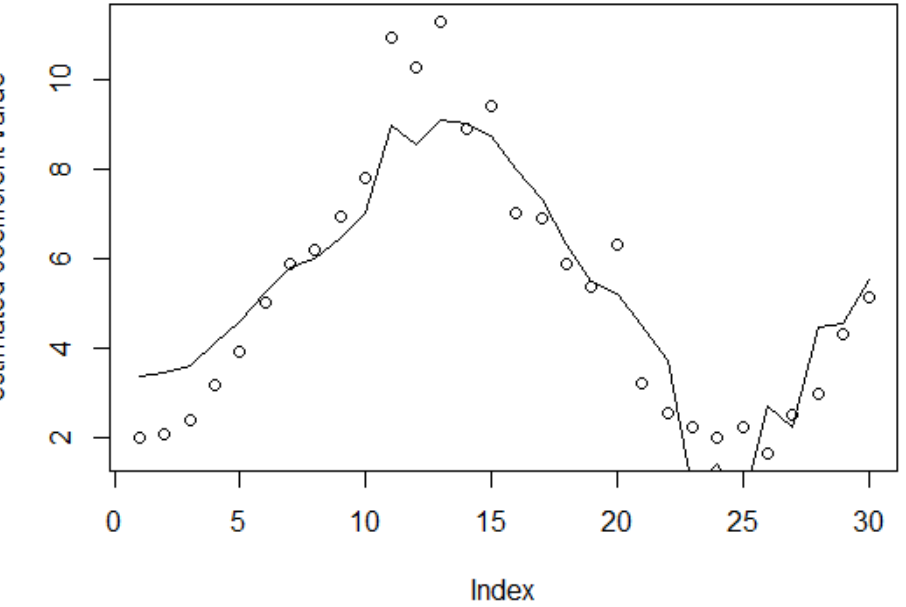
Figure 6. Coefficient value dynamics for β t 3 .